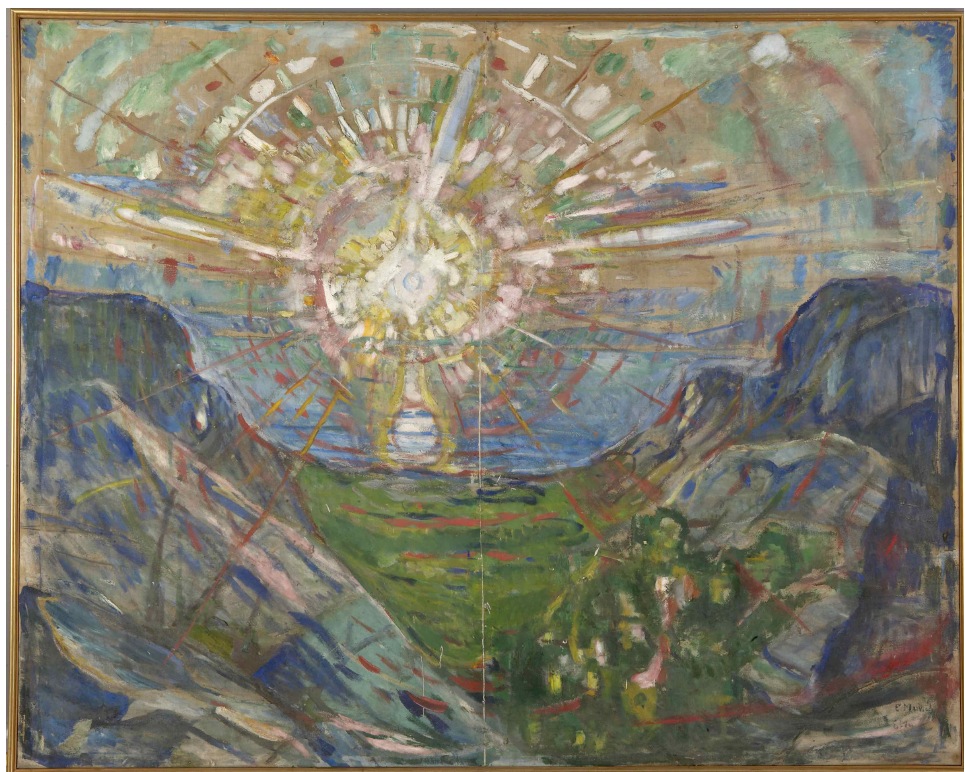
Figure 12: The Sun (1910-13) ©